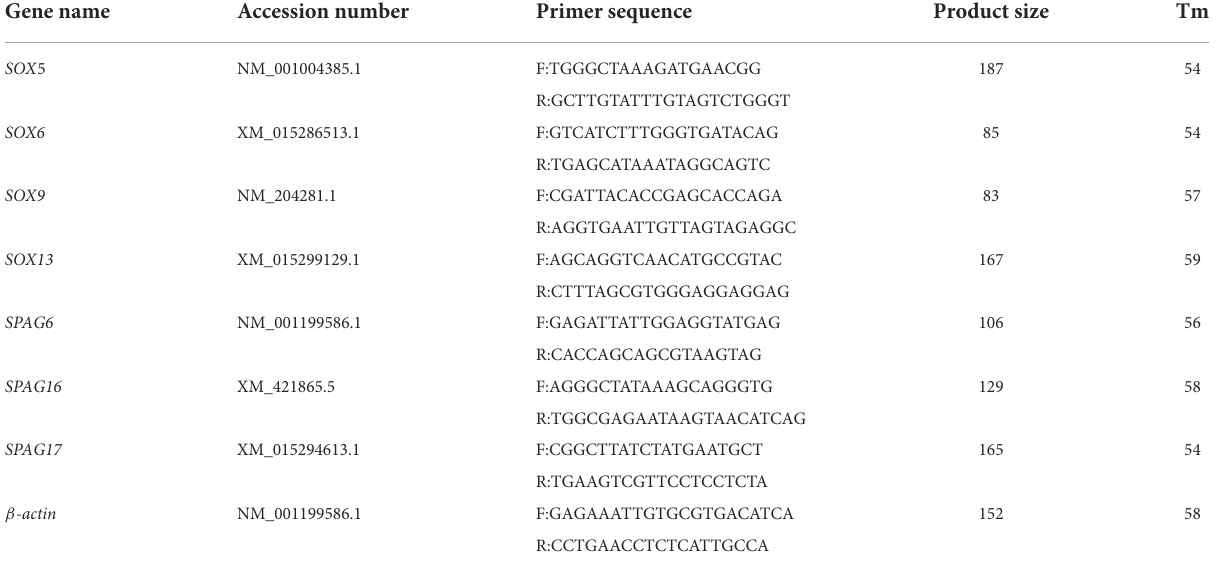
TABLE 2 Primers information of genes used in RT-qPCR.